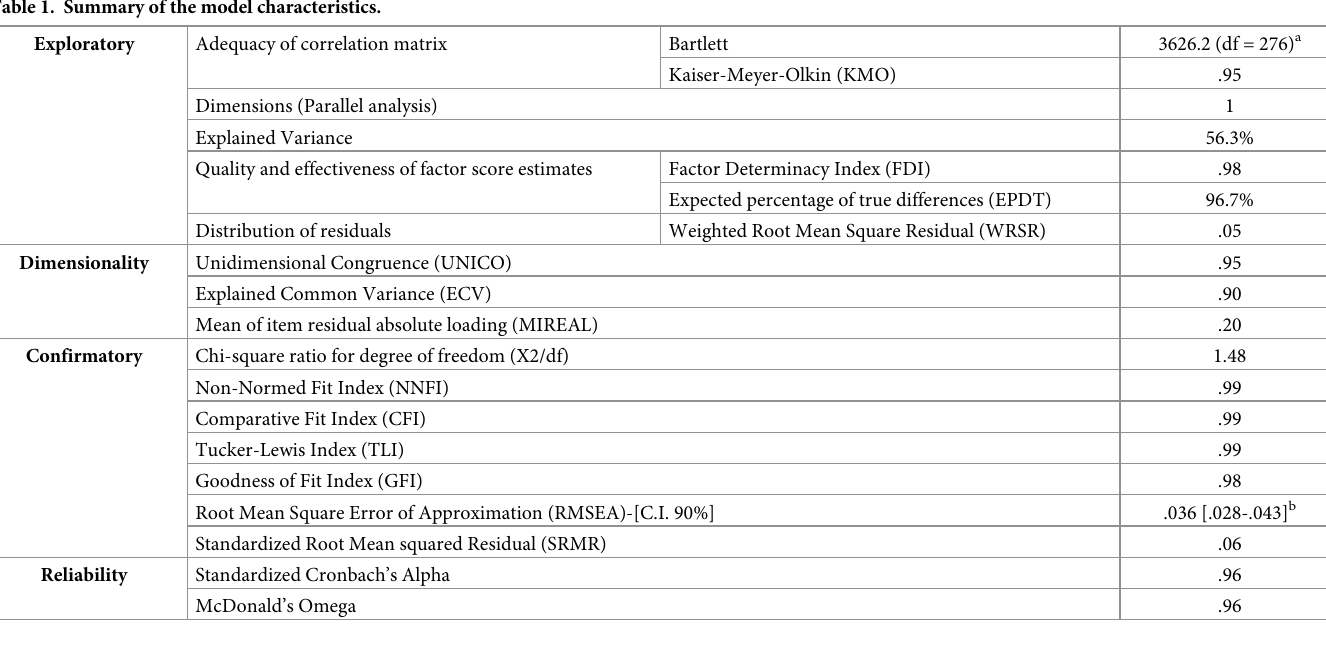
Table 1. Summary of the model